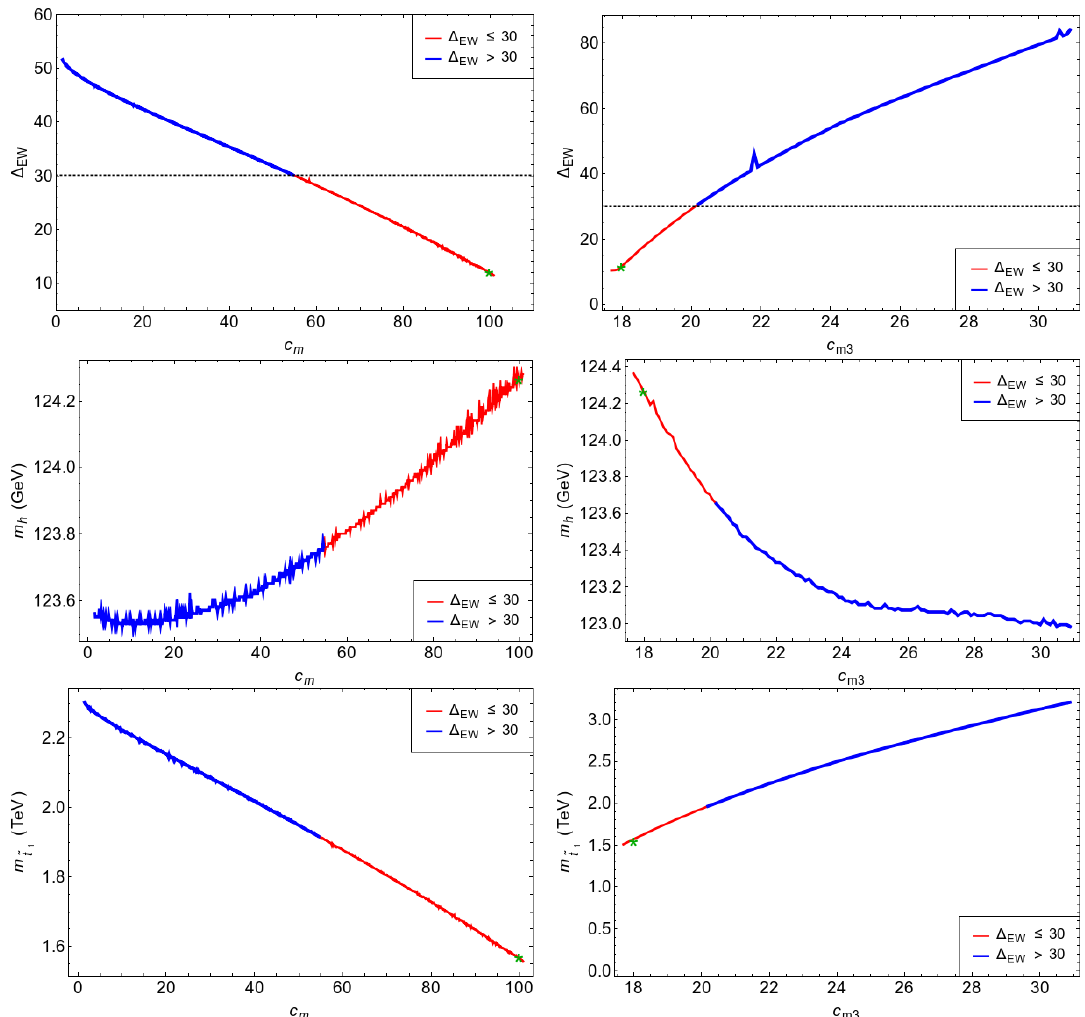
Figure 3 . (cid:1) EW , m h and m ~ vs. variation in c m and c m 3 for the mini1 benchmark point. The red t 1 portion of the curves has (cid:1) EW < 30. The green star denotes the mini1 benchmark point.